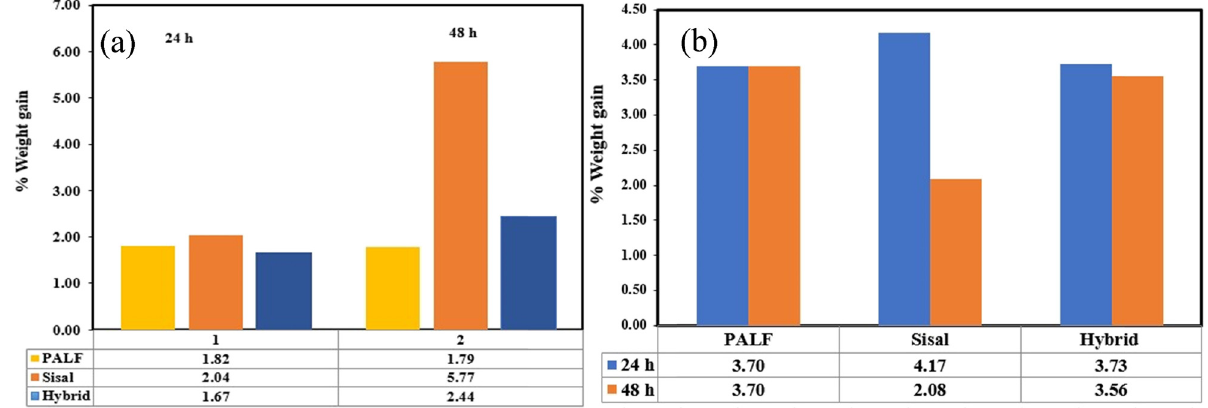
Figure 3: Water absorption nature of ( a ) fresh epoxy composites and ( b ) 1 - year - aged epoxy